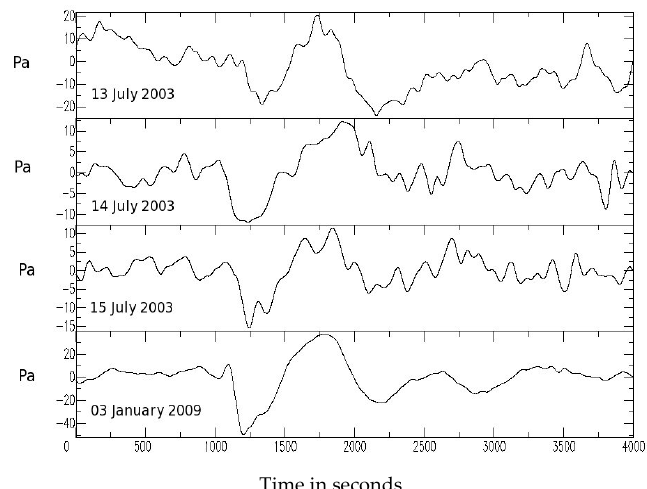
Figure 9. Surface pressure observations from microbarographs at station AIRS (approximately 5 km from the source) on Montserrat on the days shown, showing the surface pressure signal (in Pascal, 1 mbar = 100 Pascal) for four eruptions. Each eruption occurs shortly before the downward motion after time 1000 s (from Baines and Sacks [2]).